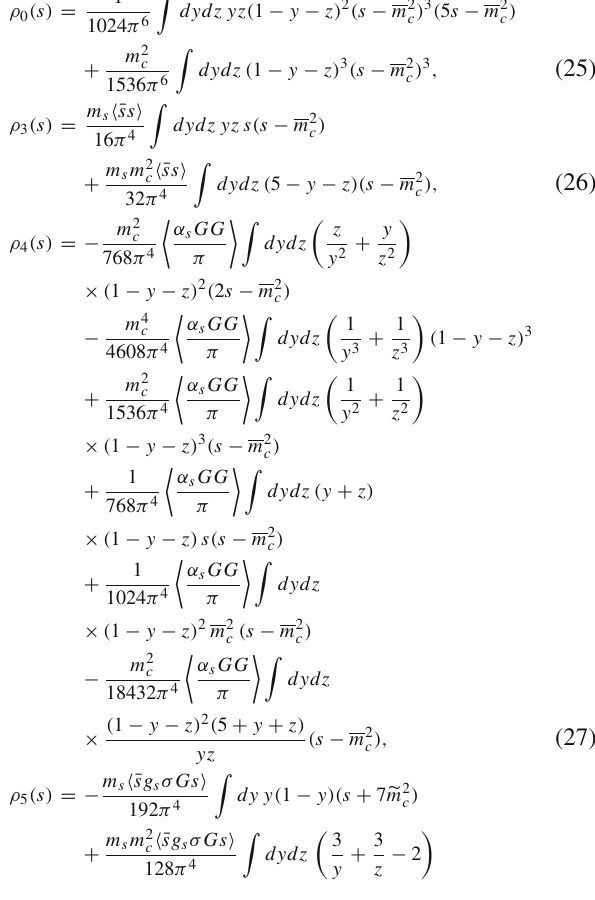
4 . 230 GeV, so the Y ( 4260 / 4220 ) is unlikely to be a pure vector tetraquark